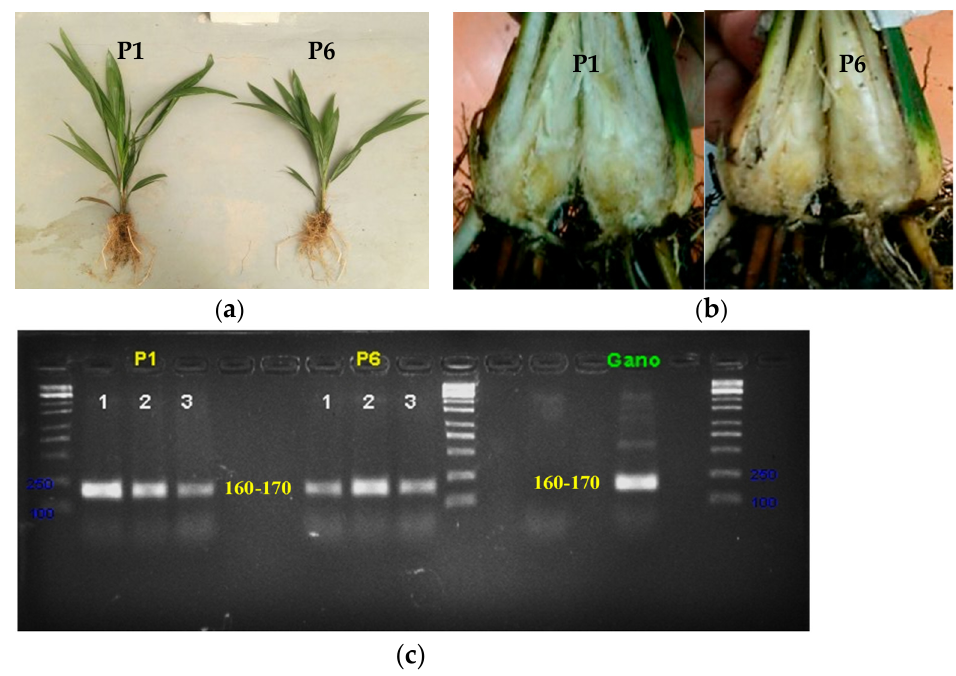
Figure 4. Sample of infected seedlings: ( a ) physical condition, ( b ) brown discoloration at the bole of the seedlings, ( c ) PCR amplification using specific primer of G. boninense .